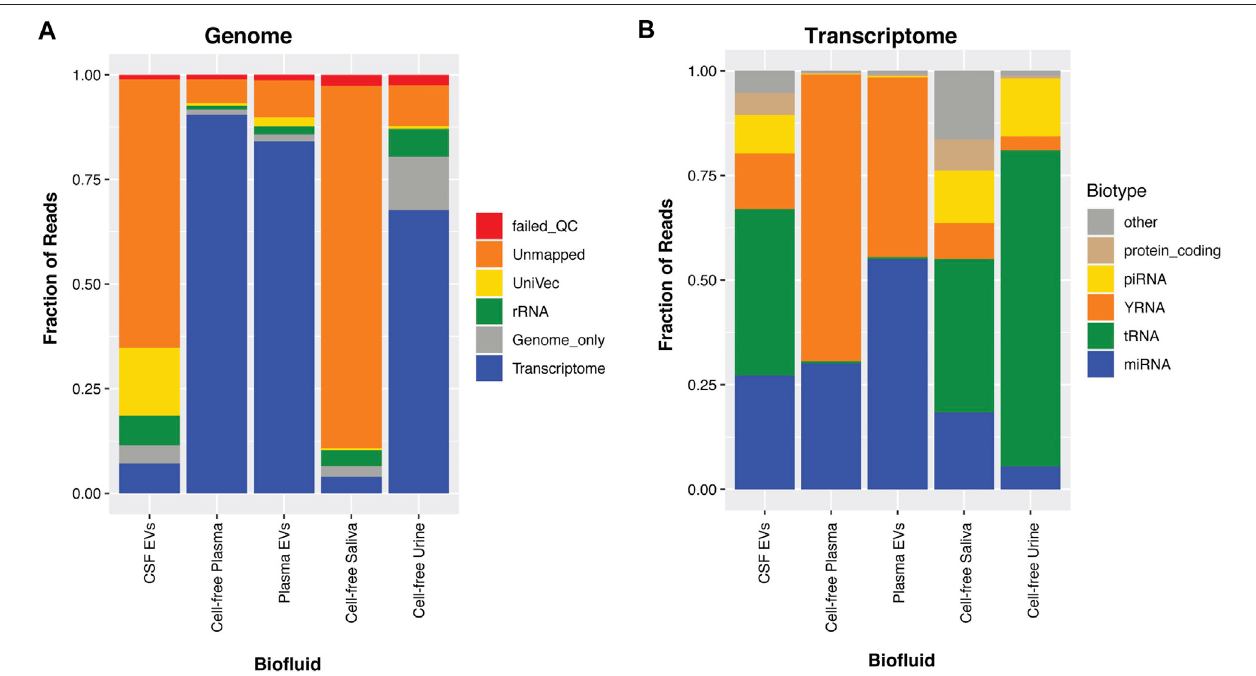
FIGURE 1 | Bio fl uid Pro fi les. For the bio fl uids, CSF-EVs, cell-free plasma, plasma-EVs, cell-free saliva and cell-free urine, the associated small RNAs were sequenced and aligned to the human genome (A) . In Panel (A) , the reads are aligned to the transcriptome, genome, rRNA, UniVec (laboratory contaminants), are categorized as unmapped, or reads that fail QC. In Panel (B) , the transcriptome mapped reads are taken out and further broken down into small RNA biotypes; miRNA, tRNA, yRNA, piRNA, protein-coding fragments, and other (these are categories of RNA that annotate in GENCODE, lncRNA fragments, pseudogenes, etc).